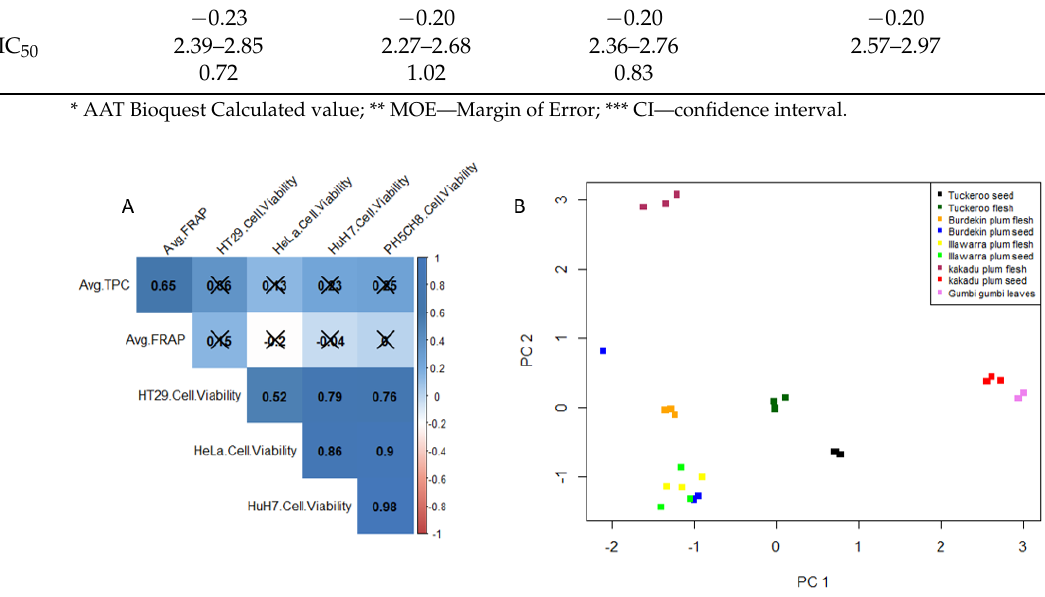
Figure 5. Kakadu plum flesh antibacterial activity.